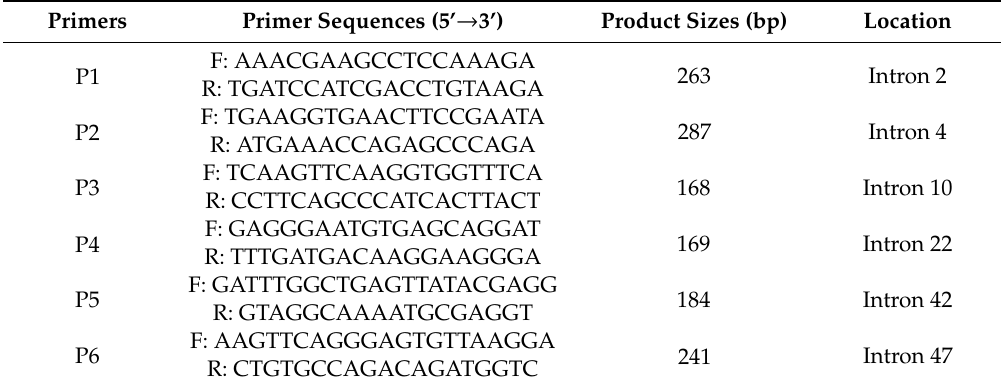
Table 1. Amplification PCR primer sequences of the goat SPAG17